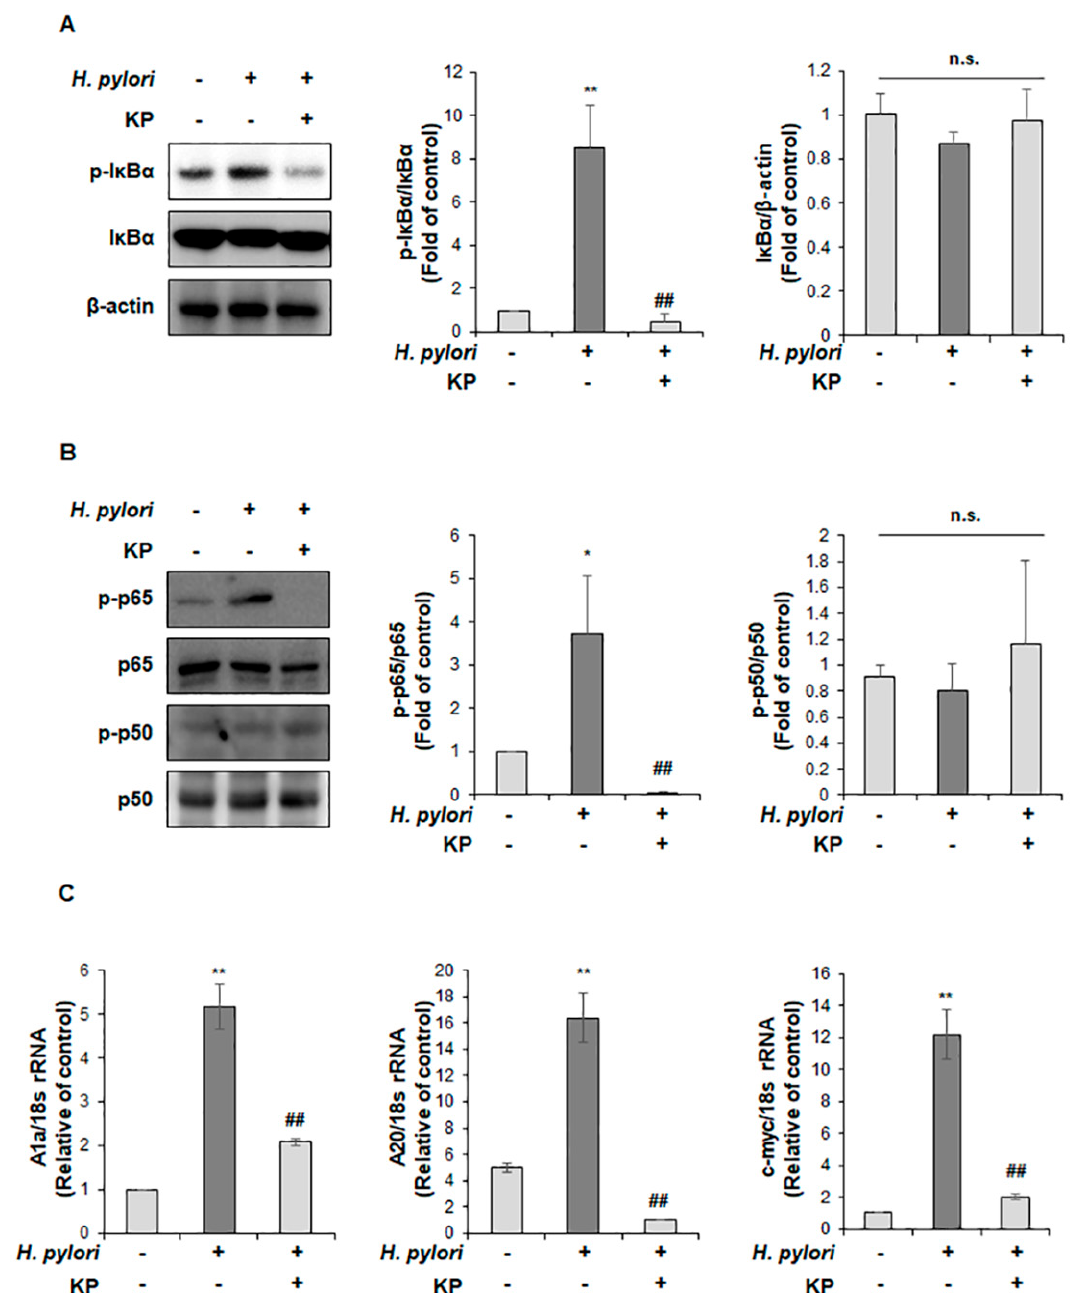
Figure 4. KP inhibits NF- κ B signaling in H. pylori -infected gastric mucosal injury mice model. ( A ) Expressions of p-I κ B α and I κ B α in gastric mucosal tissues were analyzed by Western blot analysis. β -actin was used as an internal control. ( B ) The expression of protein levels of pp65, p65, pp50 and p50 were conducted by Western blot analysis. ( C ) The mRNA levels of A1a, A20 and c-myc were determined by qRT-PCR. The 18S rRNA was used as an internal control for the mRNA levels. Data are the mean ± standard deviation (n = 4). Statistical significance was analyzed by analysis of vari- ance. * p < 0.05 and ** p < 0.01 vs. normal group; ## p < 0.01 vs. H. pylori group, significantly different compared with control.